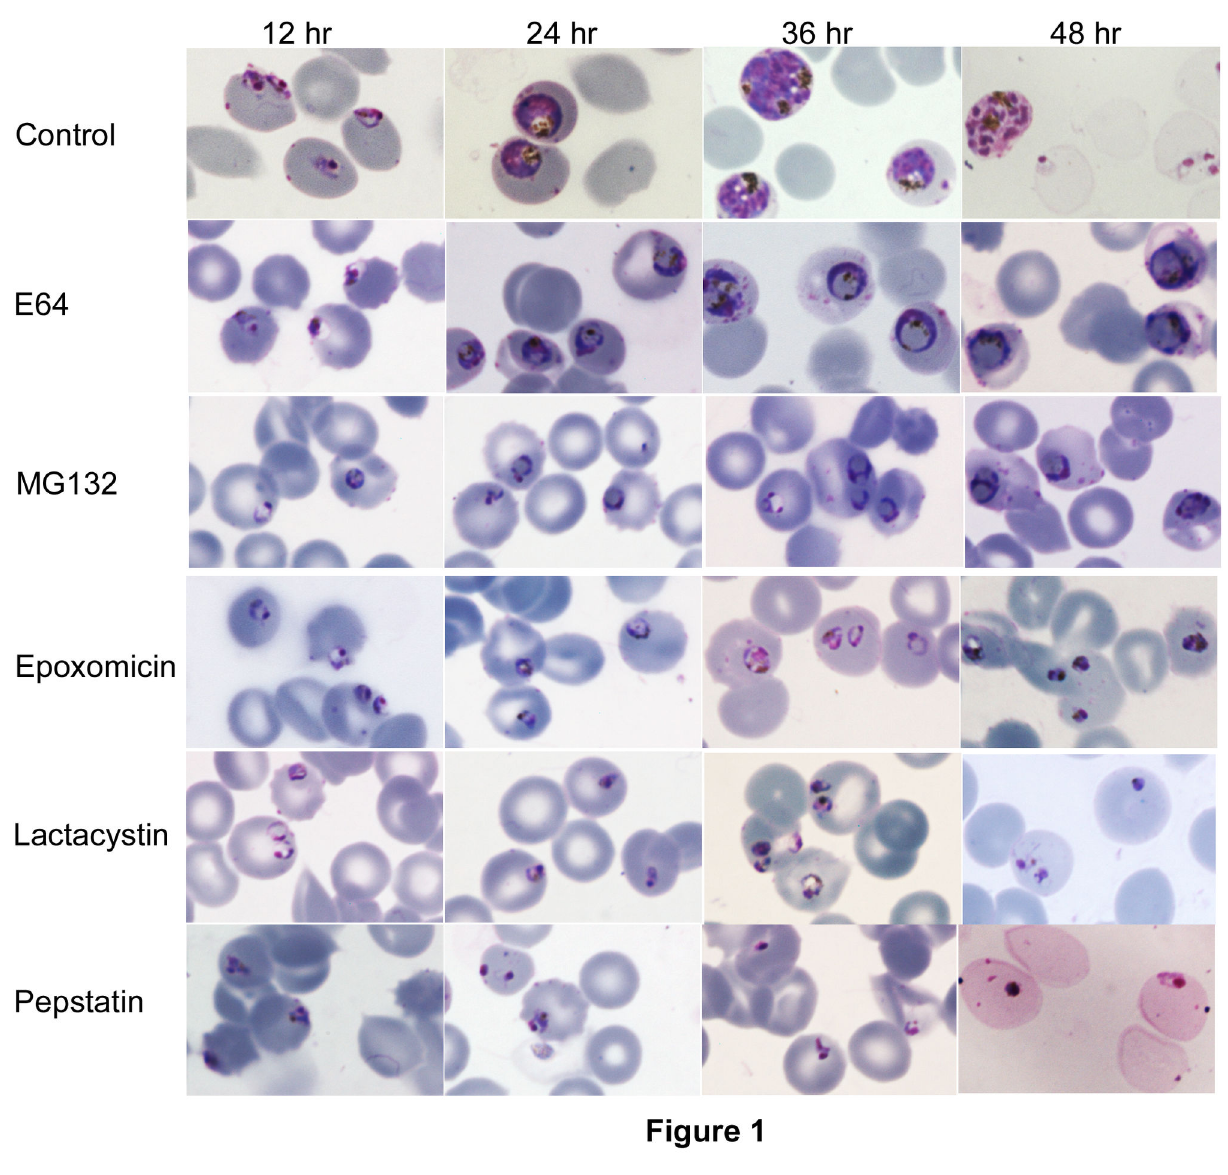
Figure 1. Morphologies of inhibitor-treated parasites. Parasites were cultured without (control) or with indicated inhibitors (21.7 µM E64, 0.024 µM epoxomicin, 0.812 µM lactacystin, 0.133 µM MG132, and 220.6 µM pepstatin; concentrations are nearly 3 times the IC ) for 48 hours, and the morphologies of parasites on Giemsa-stained smears were evaluated at indicated time points. Note 50 that both E64- and MG132-treated parasites have enlarged food vacuoles occupying almost the entire parasite, whereas parasites treated with epoxomicin, lactacystin, and pepstatin are pyknotic. doi: 10.1371/journal.pone.0073530.g001 rings at 48 hour time point, and this number almost remained (Table 2). Treatment with MG132 and epoxomicin at ring and the same (0-12%) at 60 hour time point regardless of the stage early trophozoite stages completely blocked the development, when inhibitors were added, which suggests that inhibitors and that with E64 resulted in a very small number of new rings blocked maturation of parasites. Both E64 and MG132, but not (Table 2). Treatment at the late trophozoite stage also had epoxomicin, caused food vacuole enlargement in the majority significant inhibitory effect, as only 3-11% of the total parasite (88%) of parasites regardless of the treatment time point. Thus, population was of new rings (Table 2). The number of rings in MG132 inhibits development of all asexual erythrocytic stages. the control increased from 40% at 48 hour time point to 80% at 60 hour time point; the inhibitor-treated parasites had 0-11%